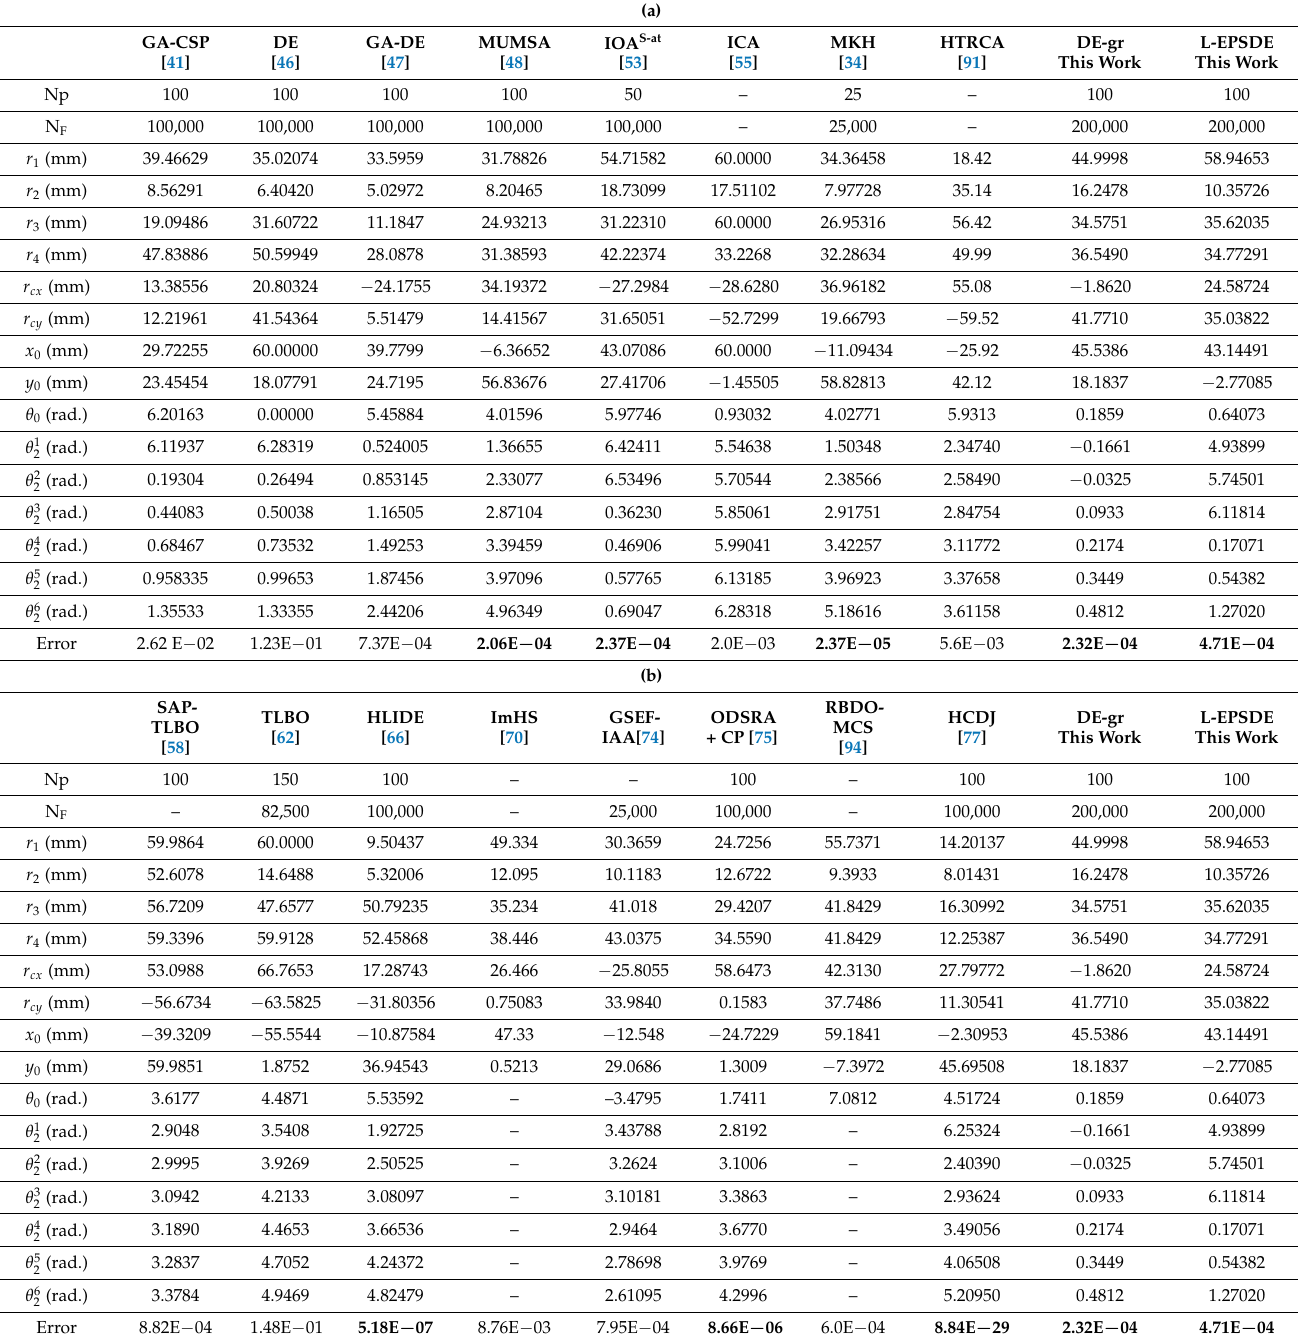
Table 6. ( a , b ) Optimal results of DE-gr, L-EPSDE, and sixteen other optimization methods for Case 4.